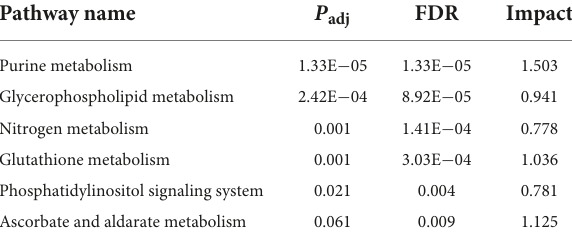
TABLE 6 Integrated pathway analysis of transcriptomic and metabolomic